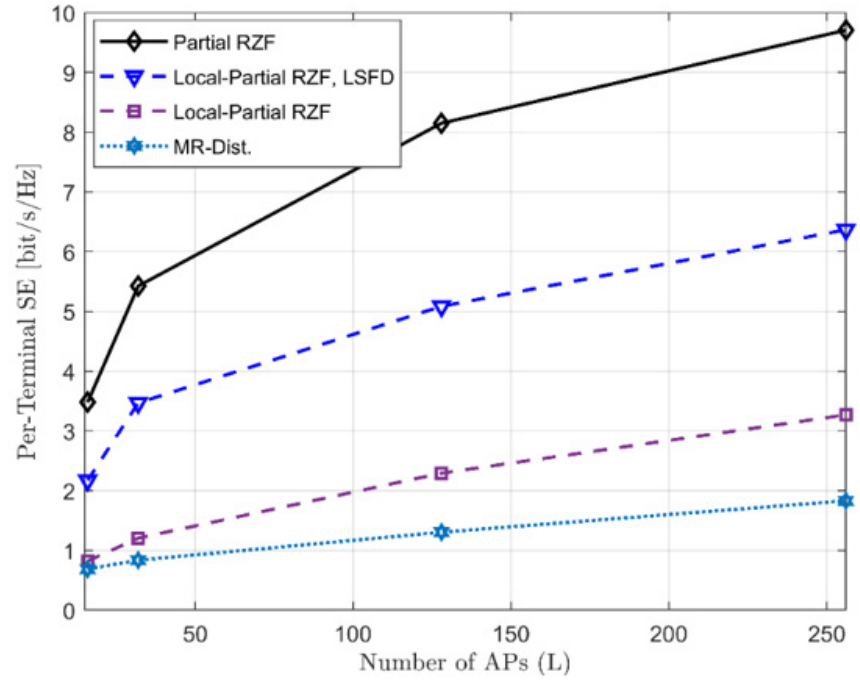
Figure 6. Average achievable SE as a function of L , with K = 8, and τ 0 = 8. Each AP is equipped by a single antenna.